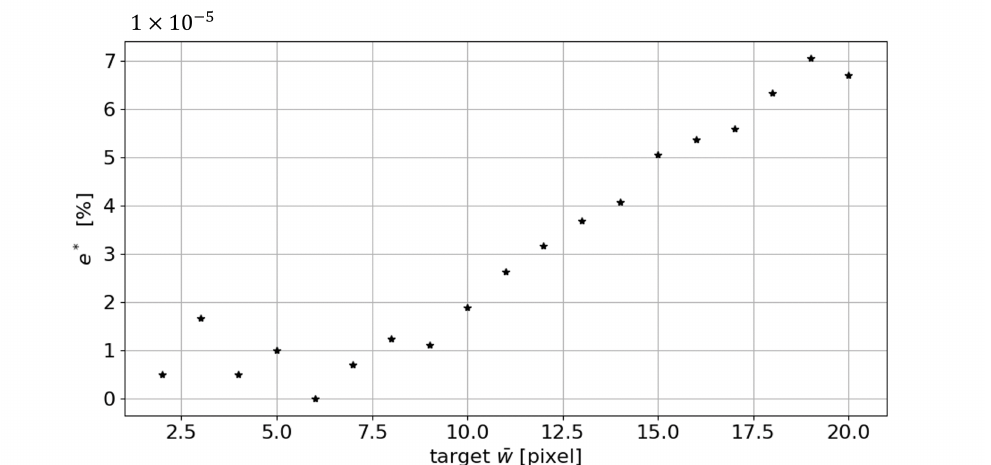
Figure 10. Absolute percentage error e ∗ trend in the measurement of the line mean width as the target ¯ w changes.